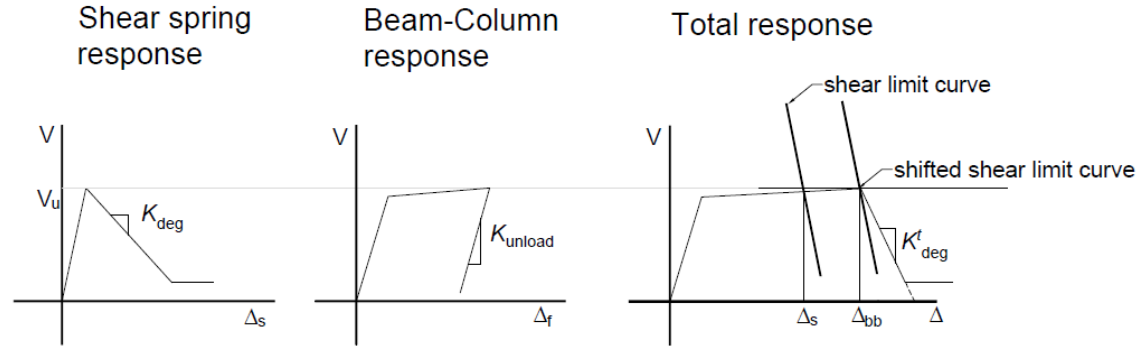
Figure 17. Buckling shear spring.